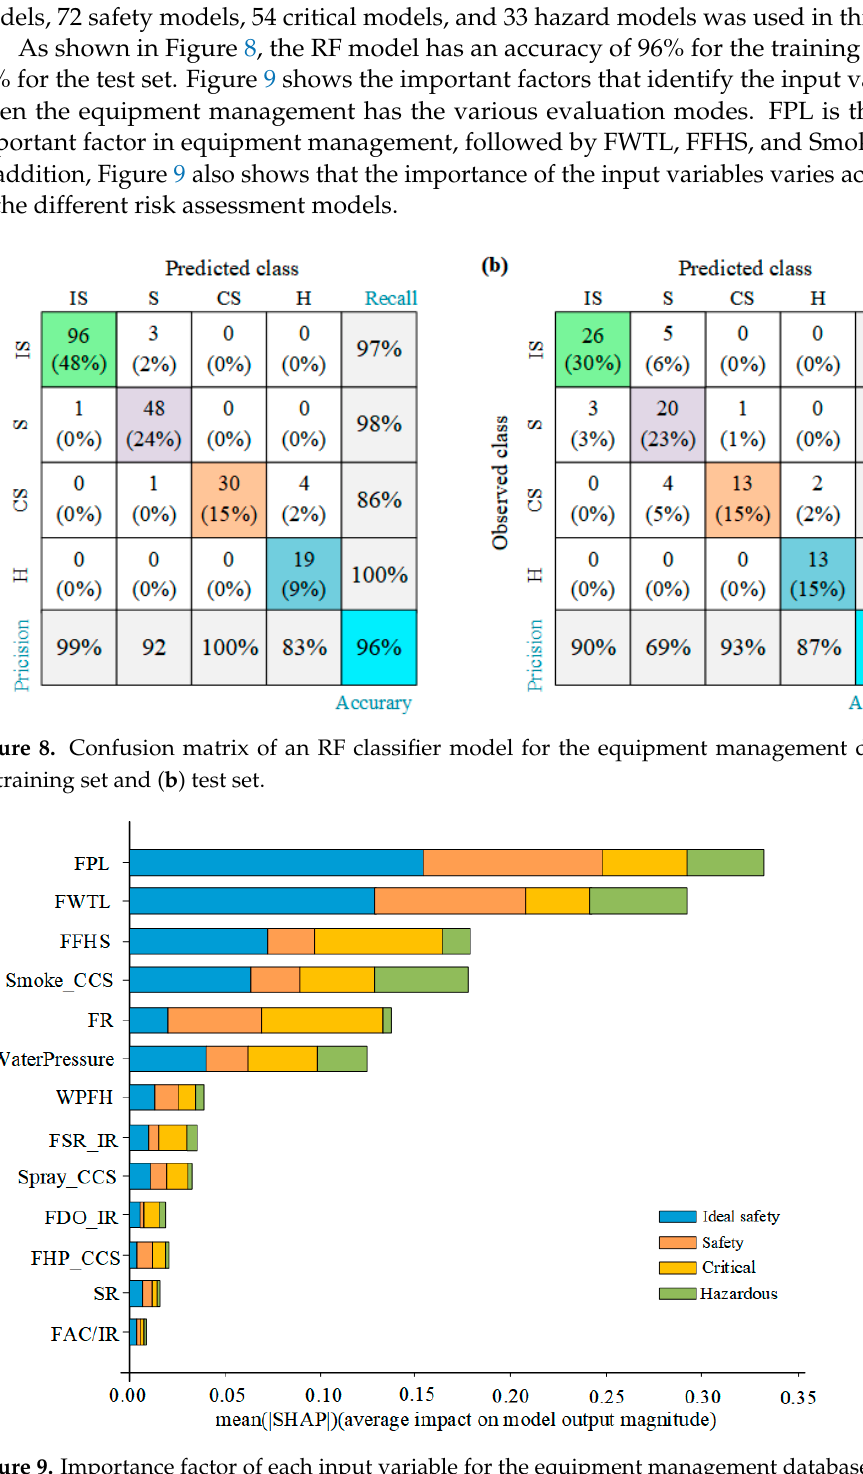
Figure 9. Importance factor of each input variable for the equipment management database.